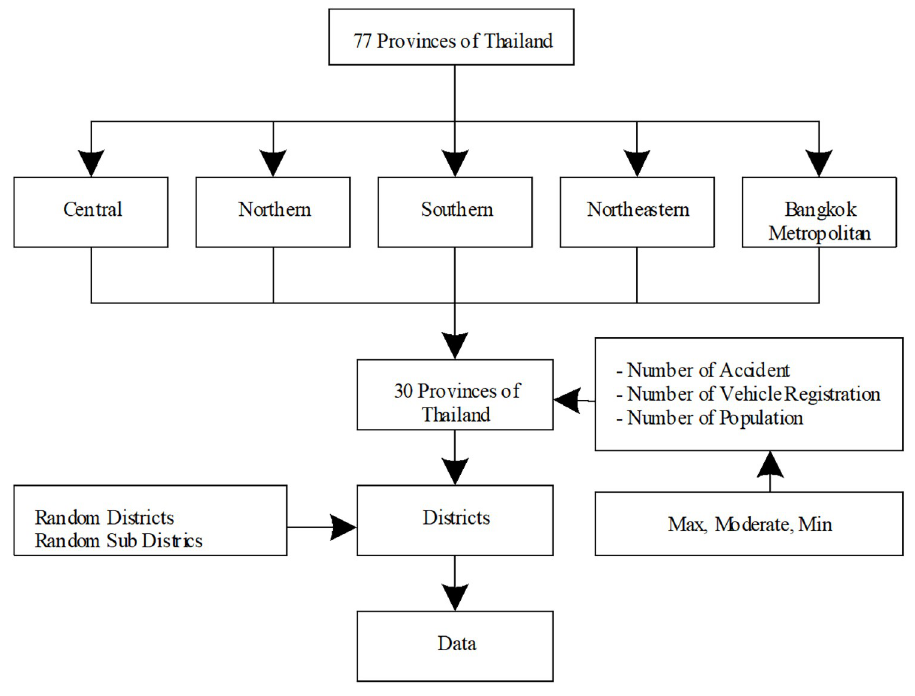
Fig 3. Data collection